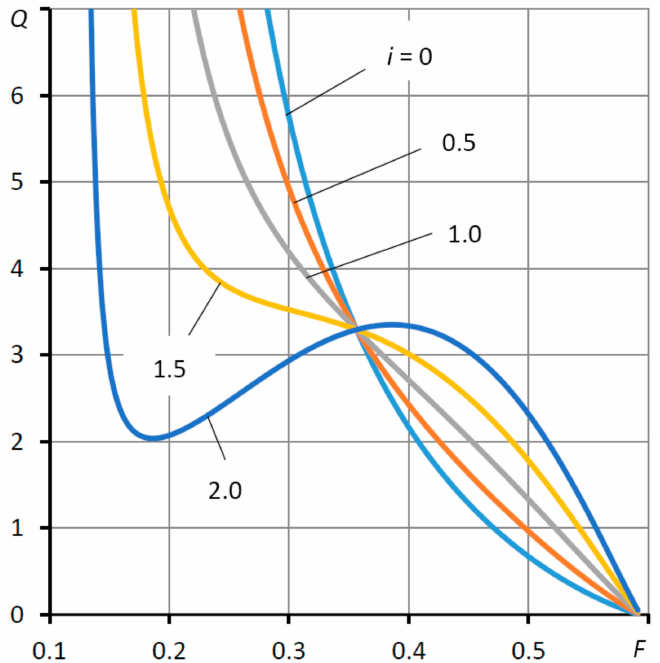
Figure 4. Flow characteristics Q ( F ) of the thrust bearing at different values of the elasticity coefficient K e = i K e 0